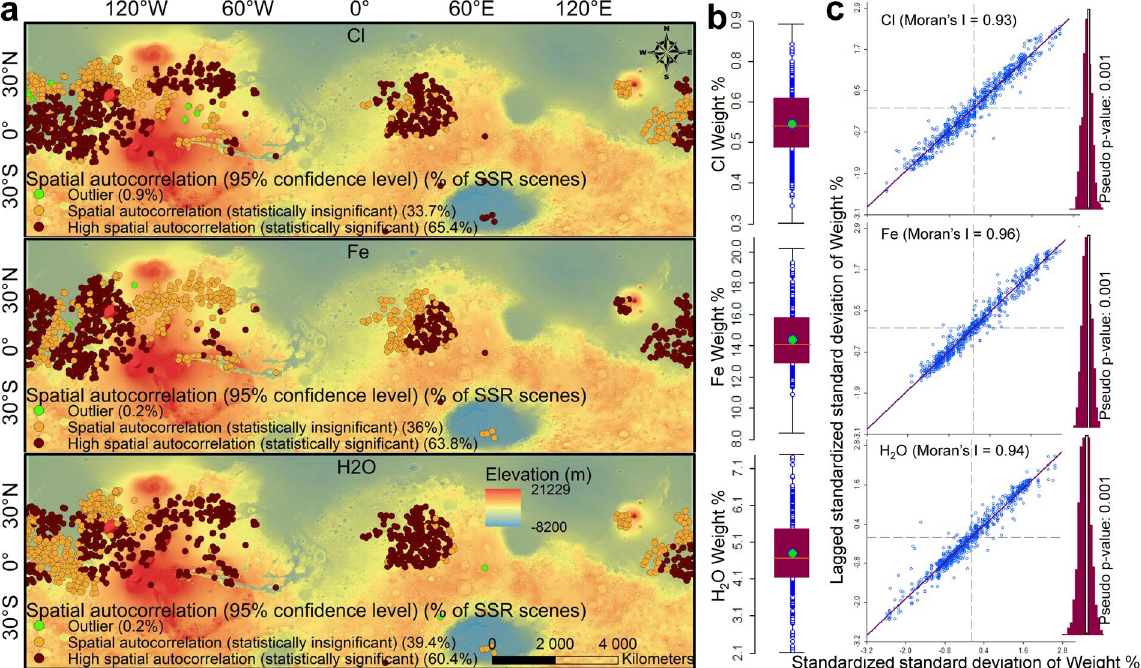
Figure 2. Anselin Local Moran’s I spatial autocorrelations within the geochemical variables in the SSR. ( a ) Spatial autocorrelation at the 95% confidence level. ( b ) Data with no outliers, i.e., normal distribution. The green circle is the average value, the maroon area is the 25% to 75% range of values, the orange line is the median, and the black lines are considered to be the limits for a normal distribution. Any circles outside the black lines are the outliers. ( c ) Moran Scatter Plots 35 . The maroon histograms represent a normal distribution after Moran’s I randomisation at 999 permutations. Mars Orbiter Laser Altimeter (MOLA) elevation-derived hillshaded view is in the background of the maps in a. The Maps are created using ArcGIS Version 10.4 (http://